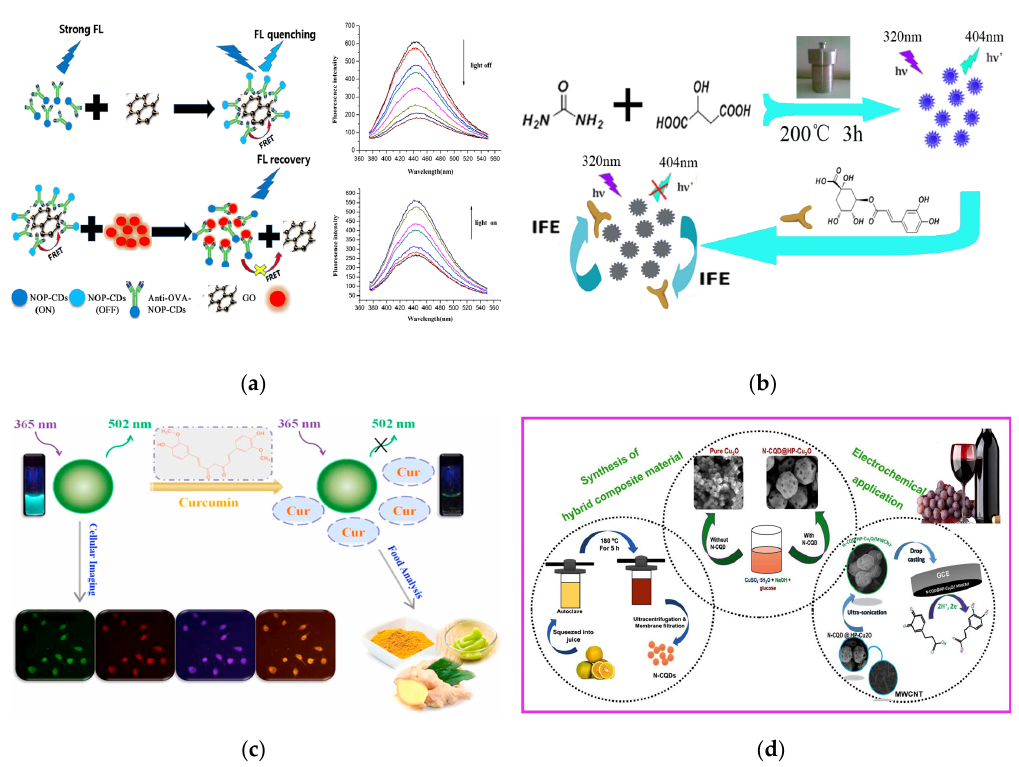
Figure5. ( a )Schematicofthequantitativedetectionforovalbumin(OVA)basedonfluorescentresonance Figure 5. ( a ) Schematic of the quantitative detection for ovalbumin (OVA) based on fluorescent energy transfer (FRET) of N, O, P co-doped CQDs (NOP-CQDs). Reproduced with permission from [91]. resonance energy transfer (FRET) of N, O, P co-doped CQDs (NOP-CQDs). Reproduced with Copyright Sensors and Actuators B: Chemical, 2018; ( b ) Schematic of the detection of chlorogenic acid in permission from [91]. Copyright Sensors and Actuators B: Chemical, 2018; ( b ) Schematic of the honeysuckle using CQDs. Reproduced with permission from [95]. Copyright Spectrochimica Acta Part detection of chlorogenic acid in honeysuckle using CQDs. Reproduced with permission from [95]. A-molecular and Biomolecular Spectroscopy, 2018; ( c ) Schematic of the quenching mechanism of Cur to Copyright Spectrochimica Acta Part A-molecular and Biomolecular Spectroscopy, 2018; ( c ) NP-CQDs and the applications of cellular imaging. Reproduced with permission from [101]. Copyright Schematic of the quenching mechanism of Cur to NP-CQDs and the applications of cellular imaging. Talanta, 2018; ( d ) Schematic of the synthesis pathway of the composite (CQDs@HP-Cu 2 O / MWCNT) composed of CQDs, hexagonal porous Cu 2 O (HP-Cu 2 O) and multi-walled carbon nanotubes (MWCNT) and ca ff eic acid detection process. Reproduced with permission from [103]. Copyright Composites Part B-Engineering,